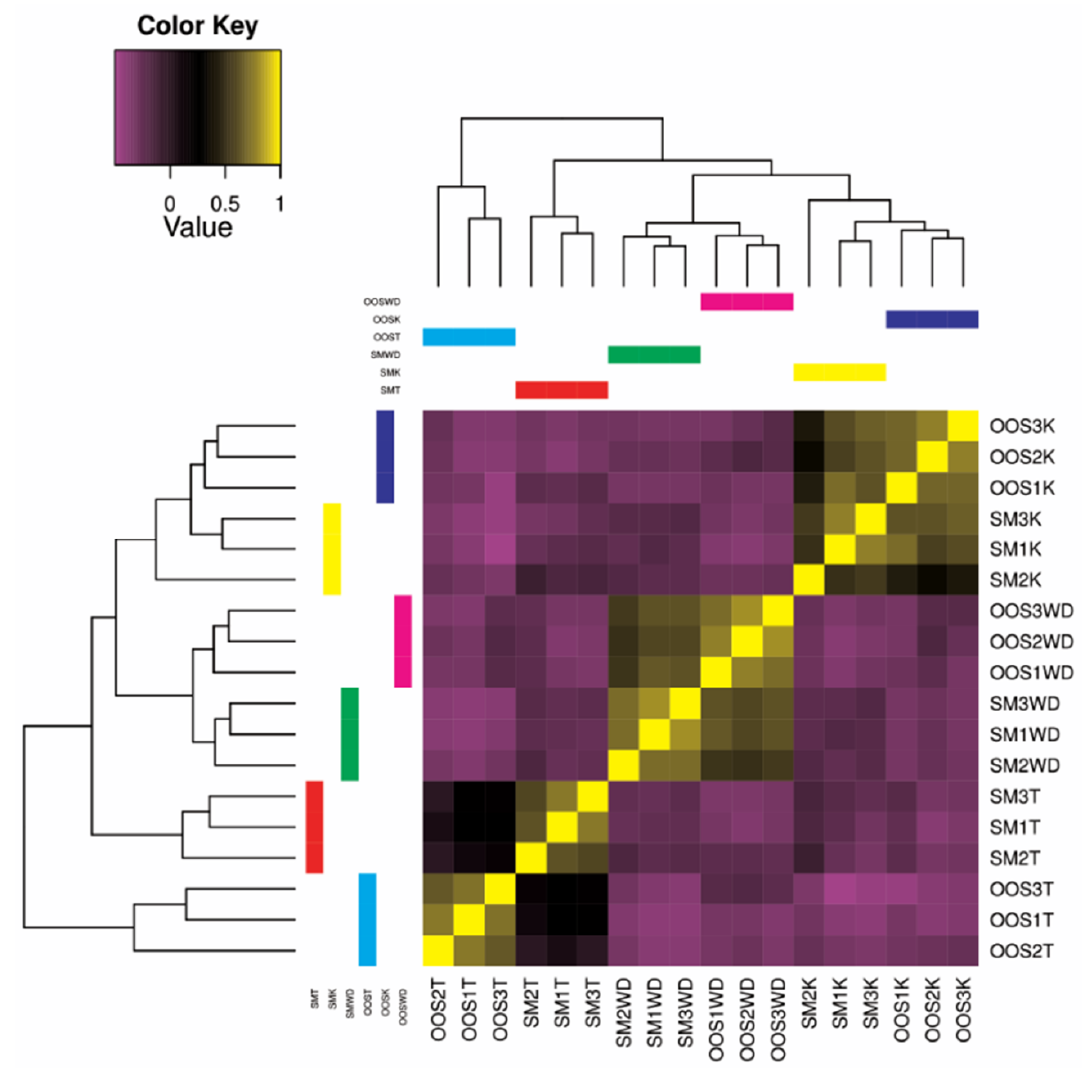
Figure 1. Sample correlation matrix heatmap, showing the degree of similarity of differentially expressed transcript clusters between each sample. SM: spermiating; OOS: out-of-spawning; K: kidney; WD: Wolffian duct; T: testes.